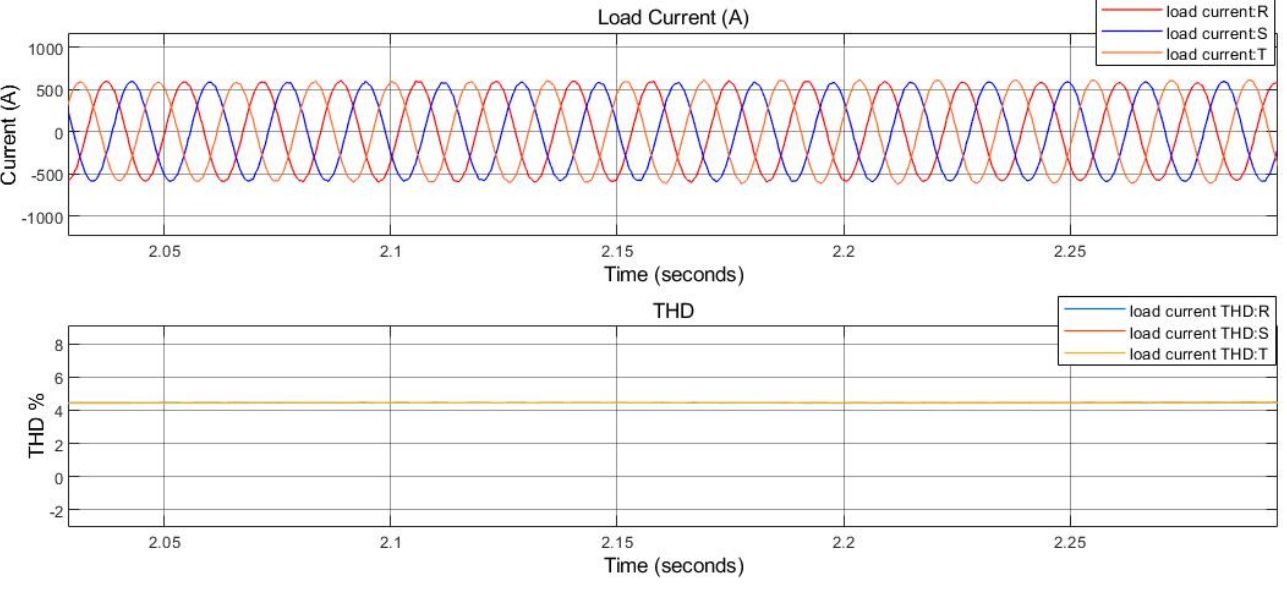
Figure 14. Load current and THD during simulation with non ‐ linear load on the grid side using hysteresis.